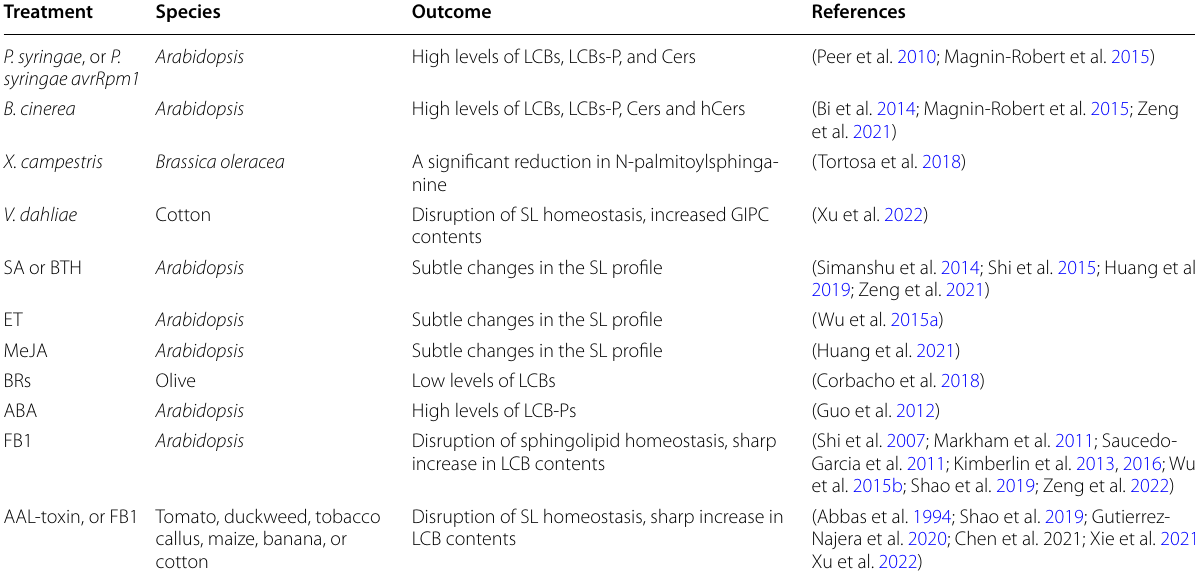
P. syringae , Pseudomonas syringae ; B. cinerea , Botrytis cinerea ; X. campestris , Xanthomonas campestris ; V. dahliae , Verticillium dahliae ; SA, salicylic acid; ET, ethylene; MeJA, methyl jasmonate; BRs, brassinosteroids; ABA, abscisic acid; FB1, fumonisin B1; SL, sphingolipid; LCBs, long-chain bases; Cers, ceramides; hCers, hydroxyceramide